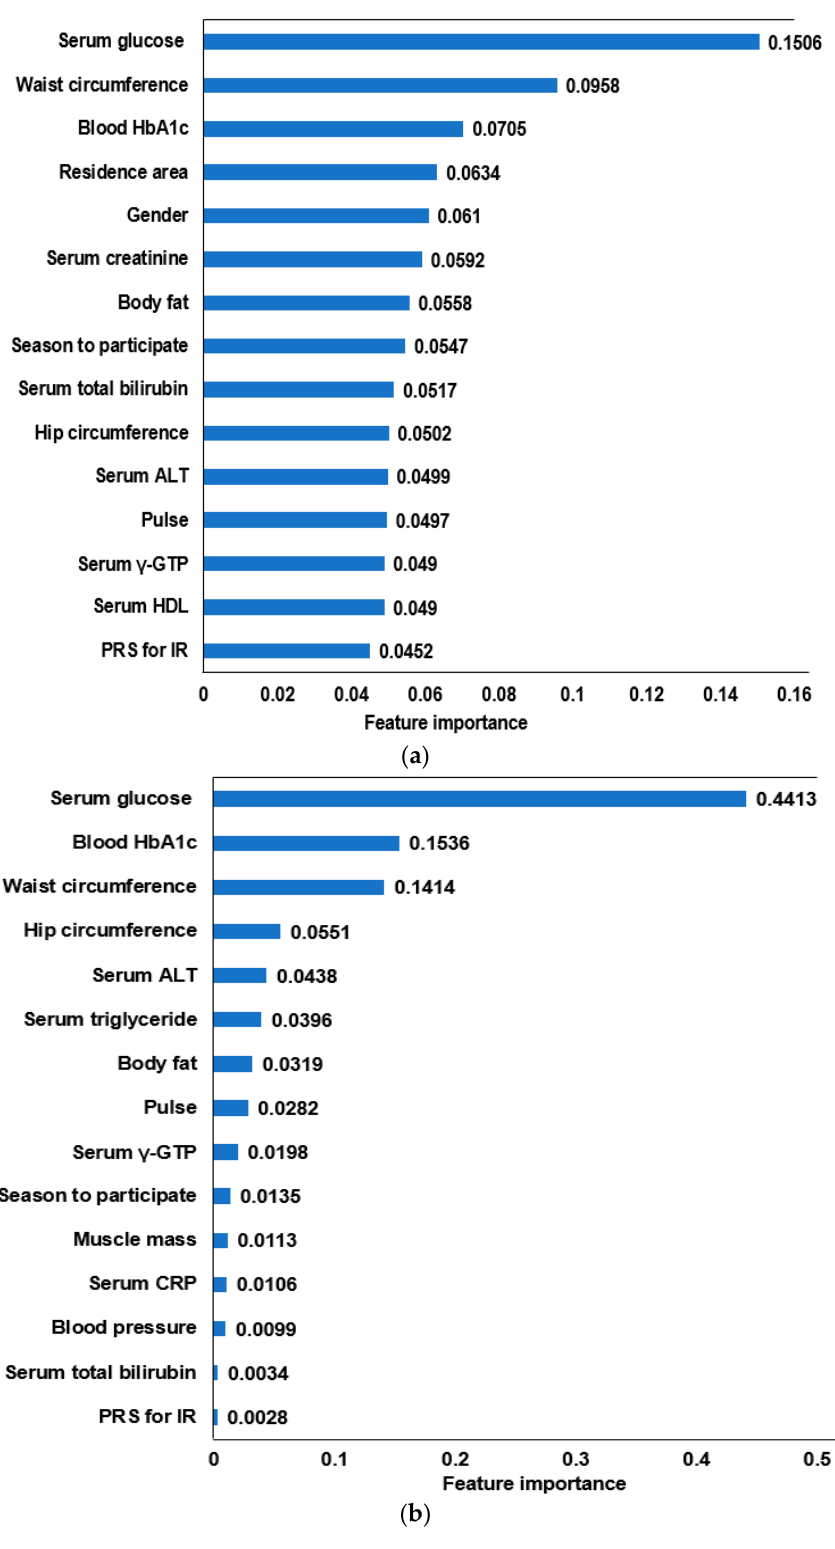
Figure 3. The relative importance of the top 15 features for predicting insulin resistance (IR), as determined by the XGBoost and random forest algorithms. ( a ) IR prediction model by the XGBoost algorithm 3. ( b ) IR prediction model by the random forest algorithm. ALT, alanine aminotransferase; HbA1c, hemoglobin A1c; γ -GTP, γ -glutamyl transpeptidase; HDL, high-density lipoprotein; CRP, high-sensitive C-reactive protein; PRS, polygenetic risk